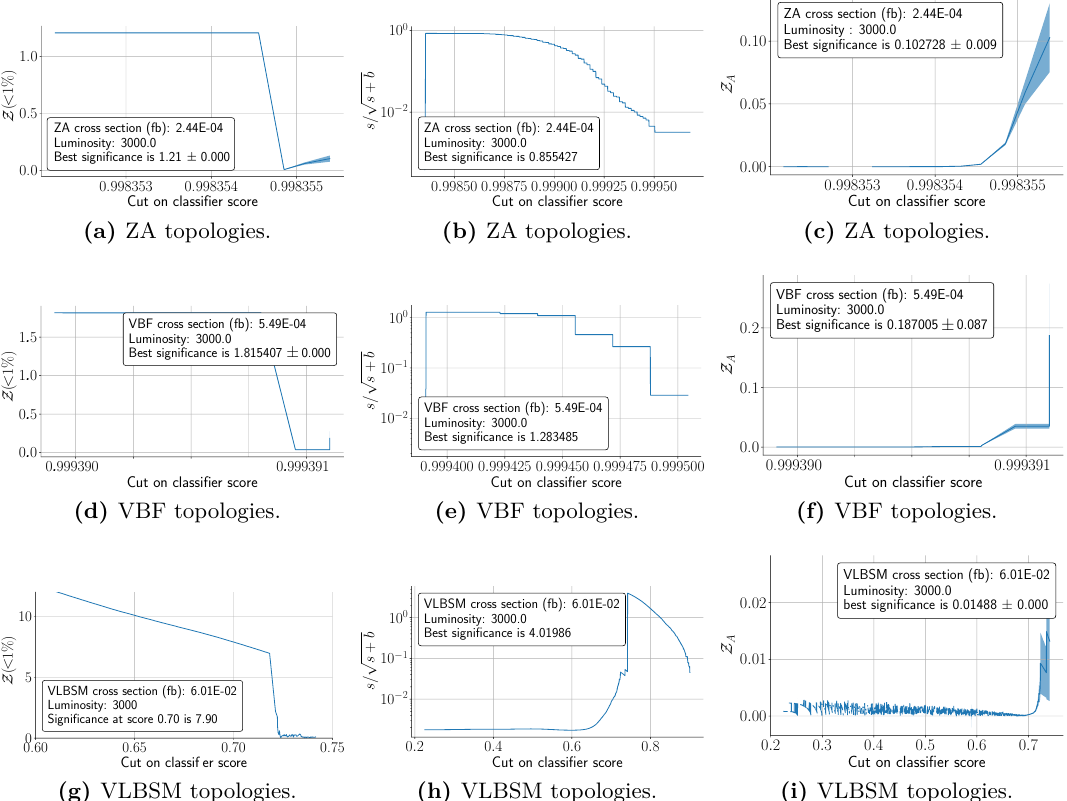
Figure 11. The same as in figure 10 but for an evolutive algorithm that maximizes the Asimov